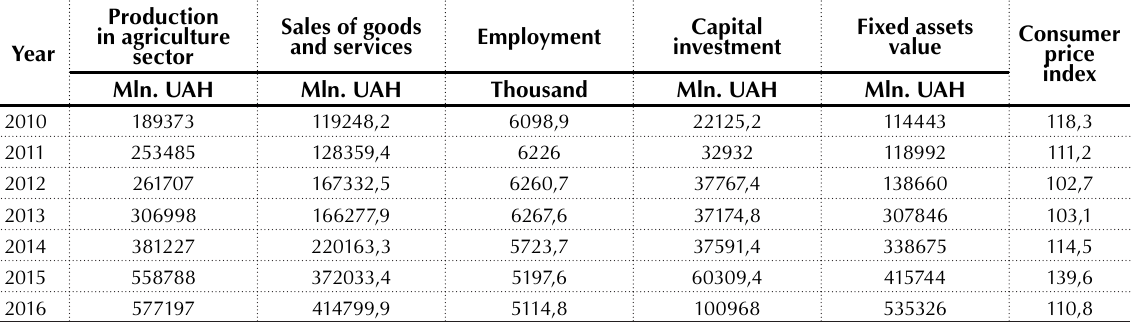
Table 1. Main indicators of agricultural development in Ukraine